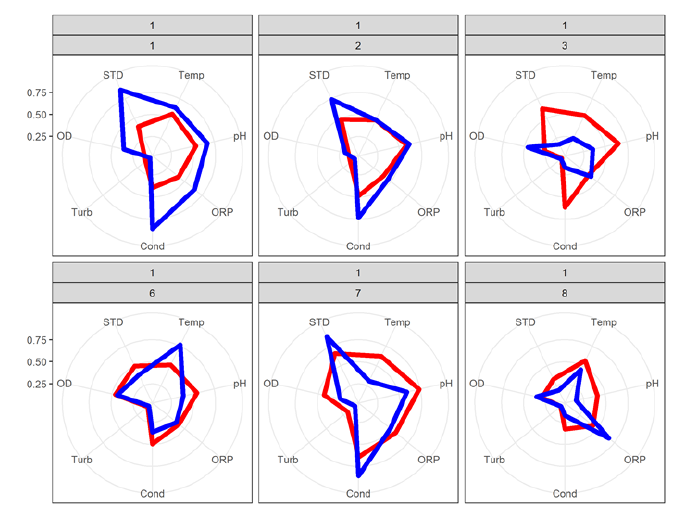
Figure 7. Correlation of water quality parameters during the wet and dry seasons in the hydrological compartment (HC) 1. Red line (dry season), blue line (wet season).